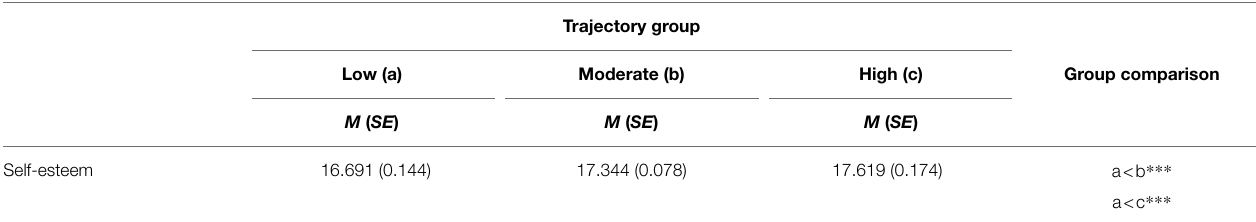
TABLE 6 | Self-esteem of first graders by trajectories of maternal responsive parenting ( n =